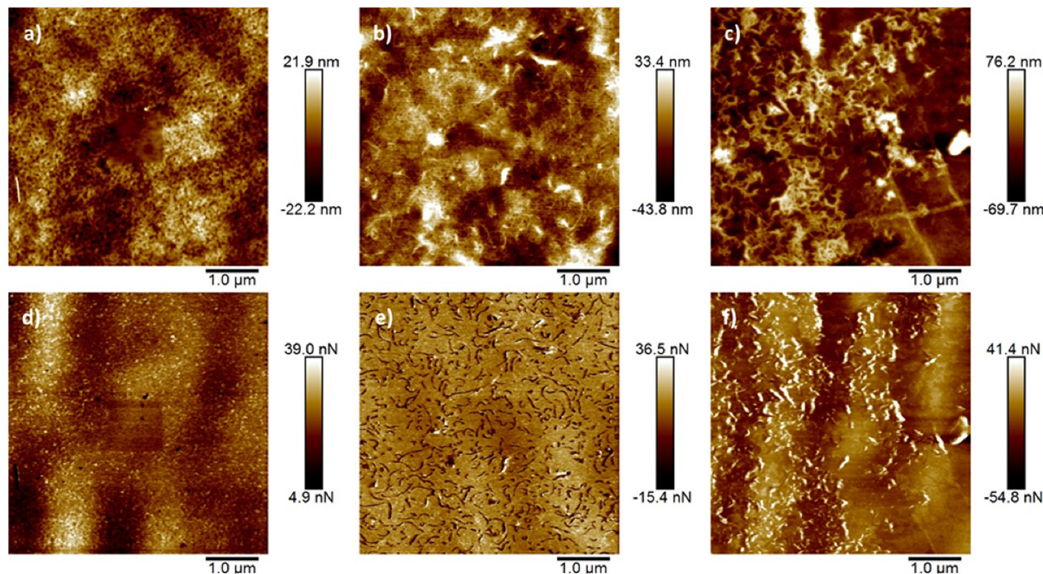
Figure 3. AFM images of PS membranes: ( a ) height image of pristine PS (root mean square roughness (Rq) for this image = 6.47 nm); ( b ) PS with commercial CNTs (Rq = 12.9 nm); ( c ) PS with produced CNTs (Rq = 25.6 nm); ( d ) adhesion map of pristine PS obtained simultaneously with image ( a ); ( e ) adhesion map of PS with commercial CNTS corresponding to ( b ); ( f ) adhesion map of PS with produced CNTs corresponding to ( c ).